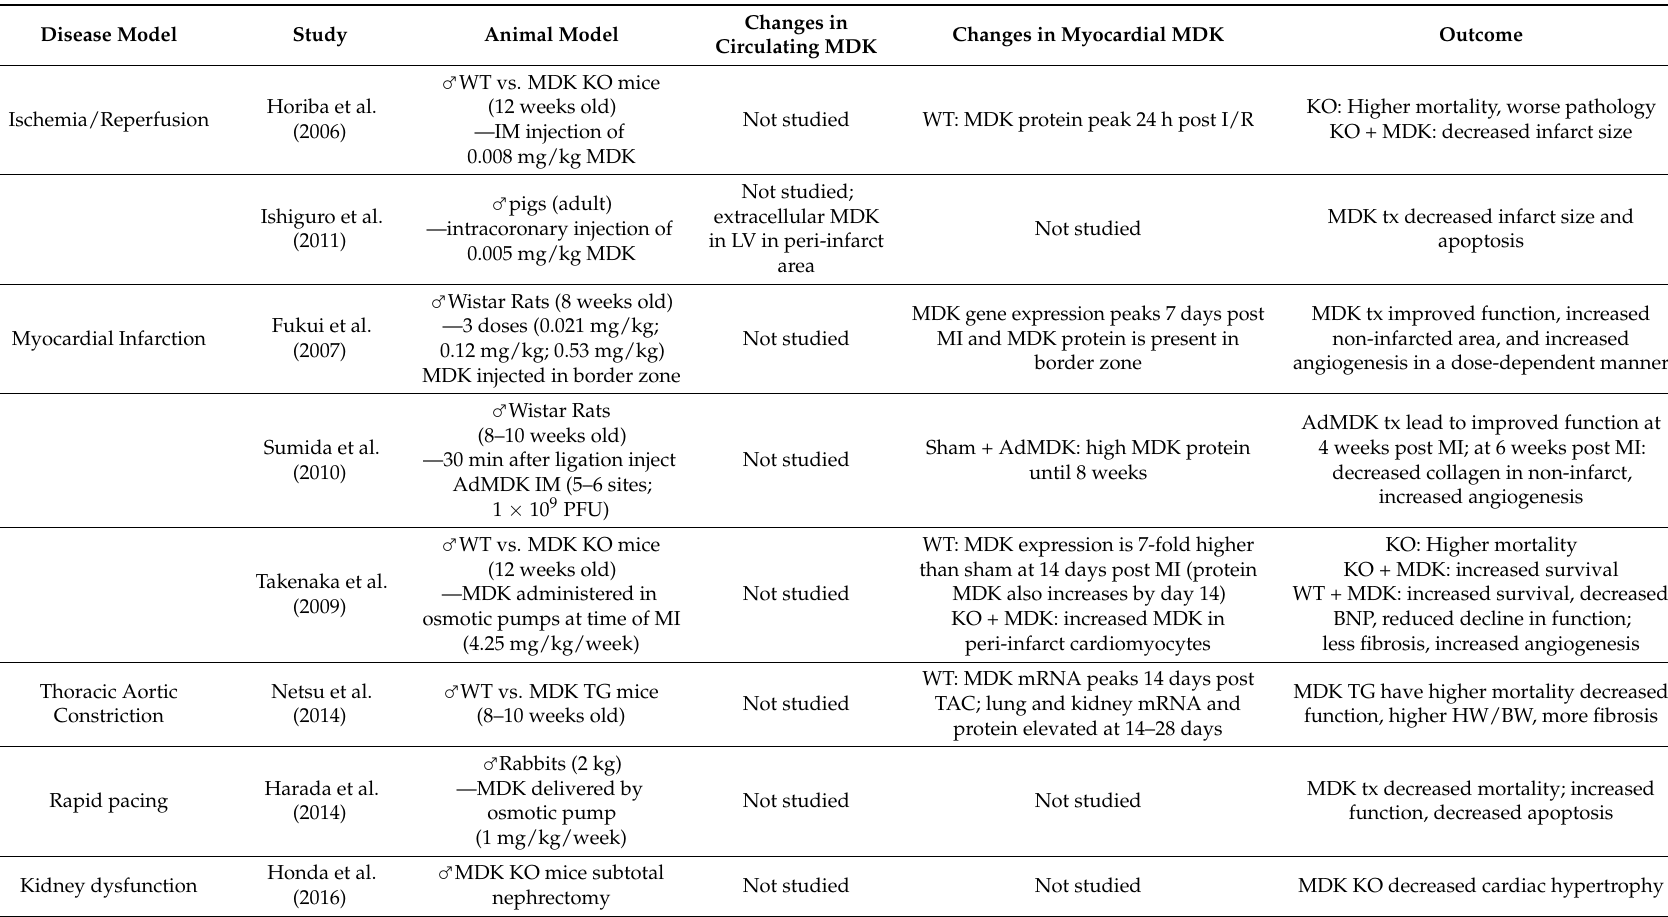
Table 1. Table summarizing current studies involving MDK and cardiac pathologies. WT = wildtype; KO = knockout; IM = intramyocardial; I/R = Ischemia/Reperfusion; Tx = treatment; AdMDK = adenoviral vector overexpressing MDK; HW/BW = heart weight/body weight; MI = myocardial infarction; BNP = brain natriuretic peptide; TAC = thoracic aortic constriction; TG =